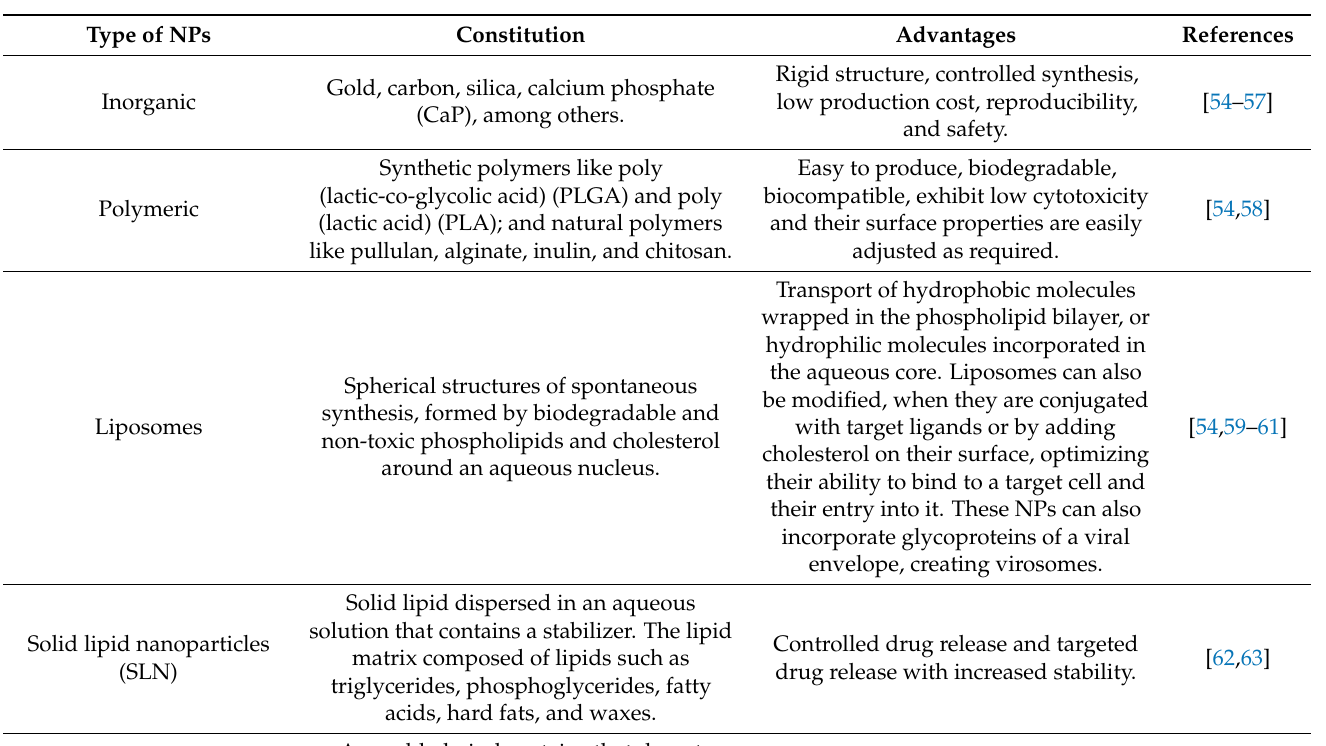
Table 1. Different types of nanoparticles used in